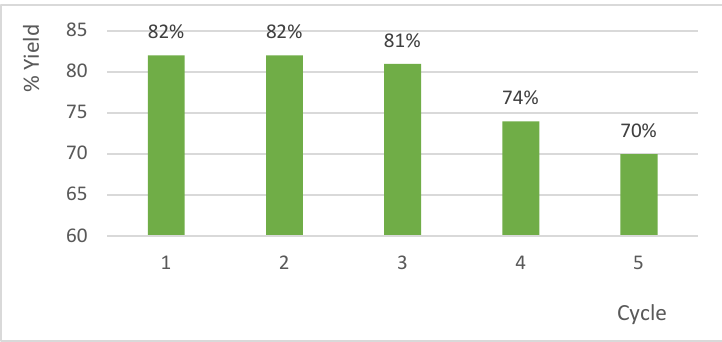
Figure 1. Percent (%) yield for every cycle run in the catalyst recycling test .